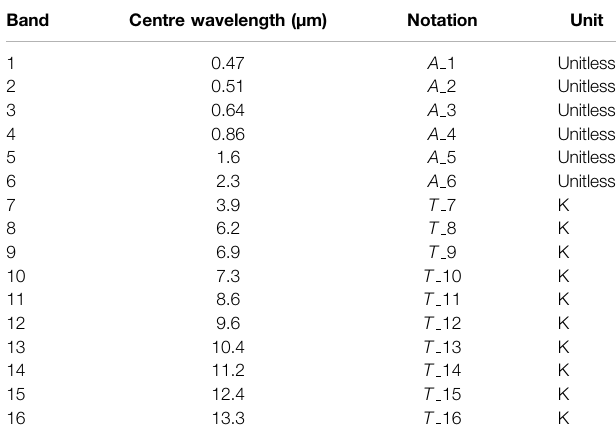
TABLE 1 | Band information of